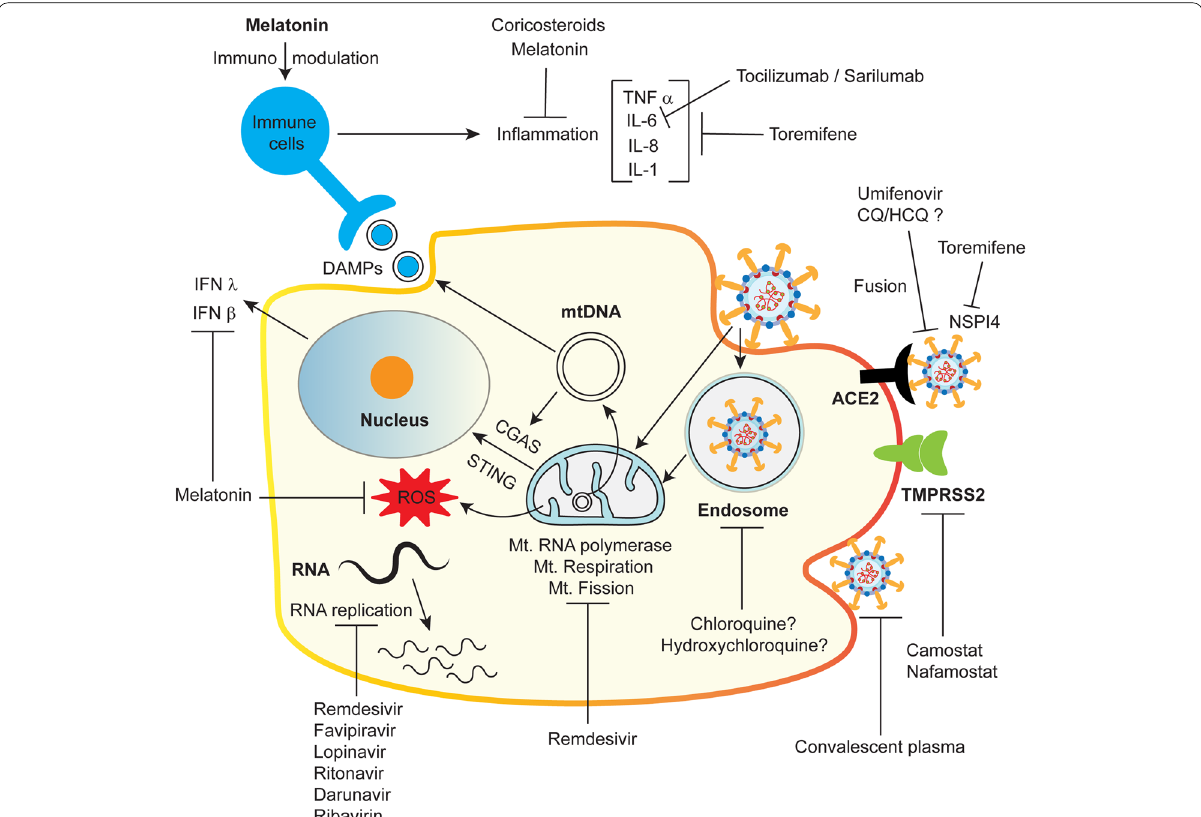
Fig. 4 Potential proposed treatments for COVID-19. Various possible treatments for COVID-19 have been proposed since the start of the COVID-19 pandemic. Most of the proposed drugs/compounds are subjected to human clinical trials alone or combined with other drugs or strategies. Various proposed drugs include 1) adenine nucleoside analogs that target the RNA-dependent RNA polymerase, which catalyzes the replication of viral RNA (e.g., Remdesivir, Ribavirin, Favipiravir), inhibits the viral RNA replication, 2) protease inhibitors (e.g., lopinavir, ritonavir, and darunavir) that inhibits protease involved in viral replication, 3) anti-malarial drugs (e.g., chloroquine (CQ) and hydroxychloroquine (HCQ)), which are proposed to inhibit ACE-2 receptor and endocytosis, 4) a selective estrogen receptor modulator (e.g., toremifene), 5) corticosteroids (e.g., dexamethasone, hydrocortisone, prednisolone) that reduce inflammation, 6) TMPRS22 protease inhibitors (camostat and nafamostate), which prevents SARS-CoV-2 binding and entry into the cell. 7) IL-6 antibodies (tocilizumab and sarilumab) to prevent IL-mediated cytokine storm, 8) COVID-19 convalescent plasma, obtained from the COVID-19 survivors to target SARS-CoV-2 with antibodies present in the convalescent plasma, and 9) Melatonin, which has multifunctions like antioxidant, anti-inflammatory, and immune